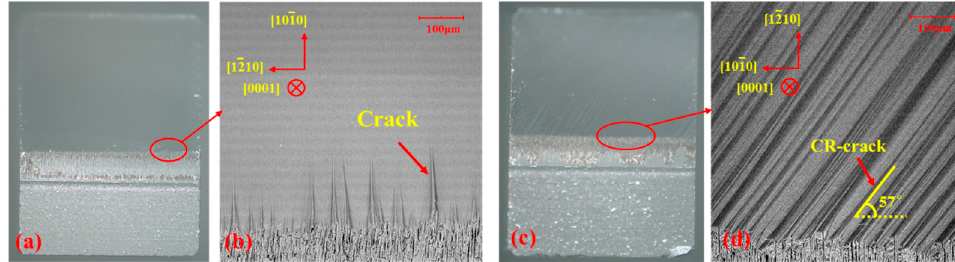
Figure 9. Morphology of the fractured surface in C-plane sapphire tests. ( a ) Fractured surface of C-M tests, “C” is the cross-section of the sapphire sample, “M” is the loaded surfaces. ( b ) Local cracks. ( c ) Fractured surface of C-A tests, “C” is the cross-section of the sapphire sample, “A” is the loaded surfaces. ( d ) Local cracks.